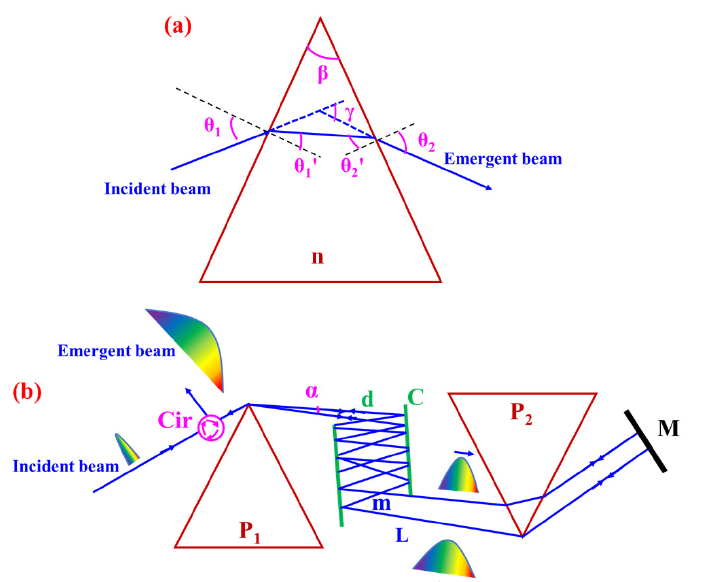
Figure 1. Schematic layout of photonic time-stretch (PTS) using prism pairs: ( a ) Geometric relationship of light beam passing through a single prism; and ( b ) principle of a two-prism pulse expander using prism pairs with negative dispersion. P, prism; C, cavity; M, mirror; Cir, circulator. The one-way total propagation length is denoted by L, which is equal to product of the cavity separation distance d and the round-trip number m